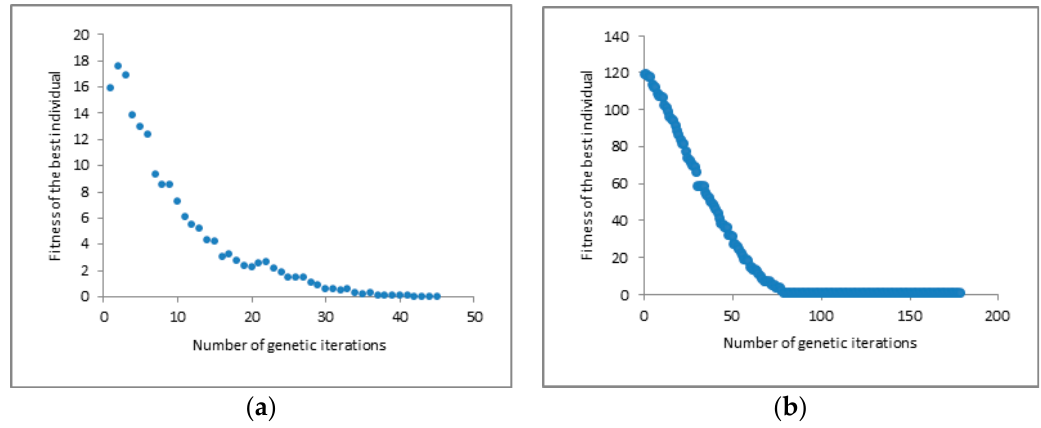
Figure 4. ( a ) Large-scale model optimization processes; ( b ) Small-scale model optimization processes.